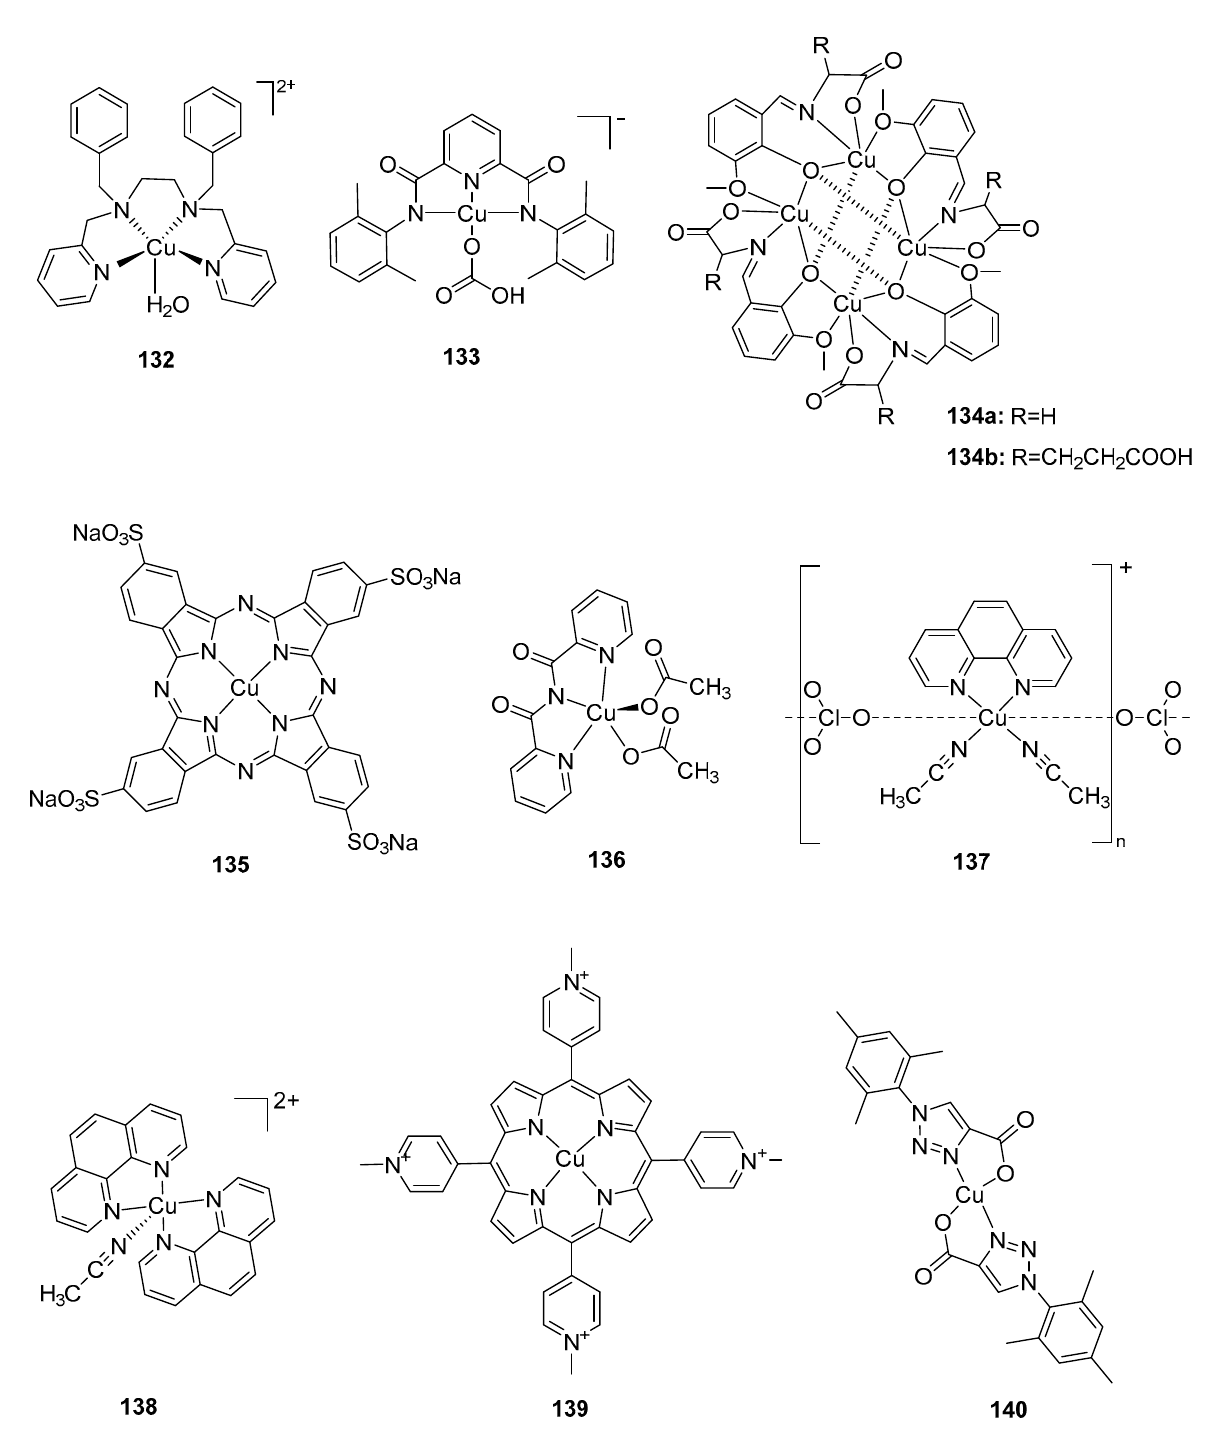
Figure 9. Selected copper complexes 118–140 for water oxidation: [Cu(bipy)(OH) 2 ] ( 118 , bipy = 2,2 ′ -bipyridine) [189]; [(TGG ) Cu-OH 2 ] 2 − ( 119 , TGG = triglycylglycine macrocyclic ligand) [190], [Cu(Py 3 P)] ( 120 , Py 3 P = N,N -bis(2-(2- pyridyl)ethyl)pyridine-2,6-dicarboxamidate) [191]; [(dhbp)Cu(OH 2 ) 2 ] ( 121 , dhbp = 6,6 ′ -dihydroxy-2,2 ′ -bipyridine) [192]; [CuL1] 2 − ( 122a , L1 = N -methyl- N’ -[2-(methylaminooxalyl-amino)-phenyl]-oxalamide)) [193]; [CuL2] 2 − ( 122b , L2 = N -[4,5- dimethyl-2-(methylaminooxalyl-amino)-phenyl]- N’ -methyl-oxalamide) [193]; [CuL3] 2 − ( 122c , L3 = N -[4,5-dimethoxy-2- (methylaminooxalyl-amino)-phenyl]- N’ -methyl-oxalamide) [193]; [CuL4] 2 − ( 122d , L4 = N -[4-methoxy-2-(methylaminoox- alyl-amino)-phenyl]- N’ -methyl-oxalamide) [193]; [Cu 2 (BPMAN)( μ -OH)] 3+ ( 123 , BPMAN = 2,7-[bis(2-pyridylmethyl)ami- nomethyl]-1,8-naphthyridine) [207], [(L)Cu(NO 3 )] ( 124 , L = (E)-3-(pyridin-2-yldiazenyl)naphthalen-2-ol) [194]; [CuH - 2 3G(OH 2 )] ( 125 , 3G = H-Gly-Dap(H-Gly)-Gly-NH 2 , Gly = glycine, Dap = L -2,3-diaminopropionic acid, the axial aqua ligands in the chemical structure are omitted for clarity) [196]; [CuH -2 2G(OH 2 )] ( 126 , 2G = H-Gly-Dap(H-Gly)-His-NH 2 , Gly = gly- cine, His = histine, Dap = L -2,3-diaminopropionic acid, the axial aqua ligands in the chemical structure are omitted for